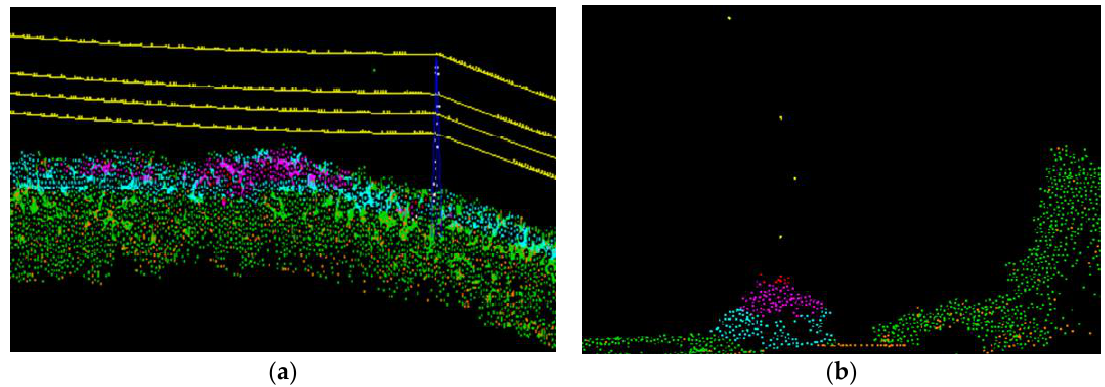
Figure 2. Highlighting of the dangerous objects (vegetation) located in the proximity of the power line protection zone: ( a ) Longitudinal section; ( b ) cross-section.